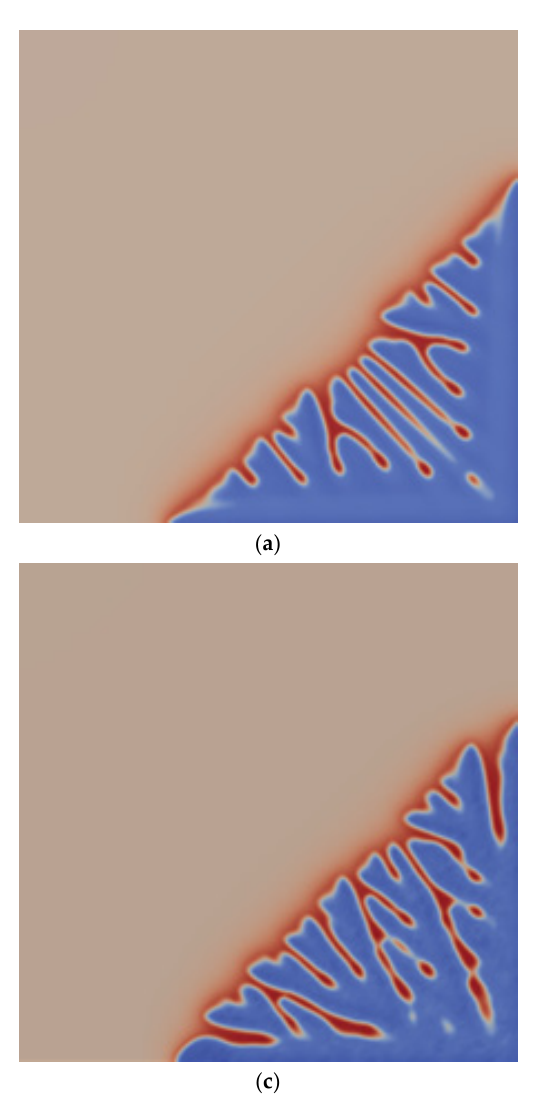
Figure 6. Solute-field diagram of dendrite morphology under different thermal disturbance values when the step size is 9000; ( a ) F u = 0; ( b ) F u = 10 − 5 ; ( c ) F u = 10 − 4 ; ( d ) F u = 10 − 3